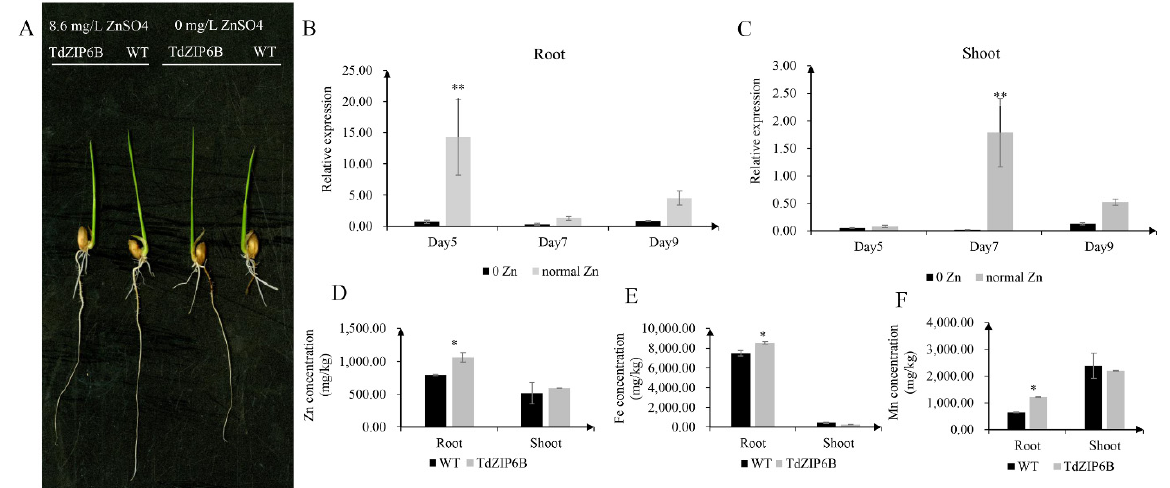
Figure 4. Comparison of phenotypes and metal concentration between TdZIP6B-1 overexpression lines (TdZIP6B) and WT plants under no Zn (0 mg/L ZnSO 4 ) and normal Zn (8.6 mg/L ZnSO 4 .7H 2 O) conditions. ( A ) Morphology of rice seedlings that were exposed to no Zn and normal Zn for 14 days. ( B , C ) The expression levels of TdZIP6B-1 in transgenic lines exposed to no Zn and normal Zn conditions for 5, 7, and 9 days. ( D – F ) The Zn, Fe, and Mn concentrations in roots and shoots of TdZIP6B and WT plants under normal Zn condition at 14 days. Error bars show SE and the symbol * and ** indicate statistical differences ( p < 0.05 and p < 0.01, respectively).